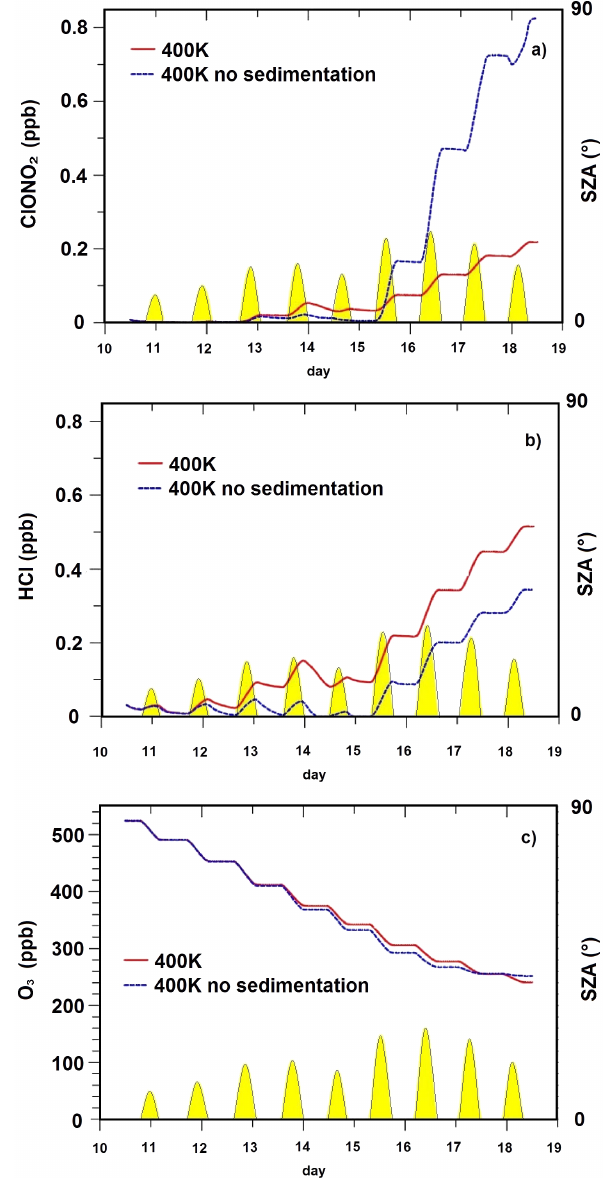
Figure 9. ClONO 2 (upper panel), HCl (middle) and O 3 (lower) evo- lution with (red line) and without (blue line) denitrification due to particle